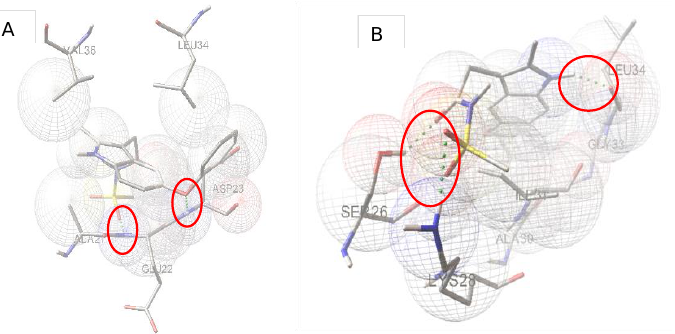
Figure 4. Docking positioning and interaction of compound 5 with ( A ) 2BEG (A β 17 – 42 ) and ( B ) 1QWP (A β 25 – 35 ); green dots are H-bonds.